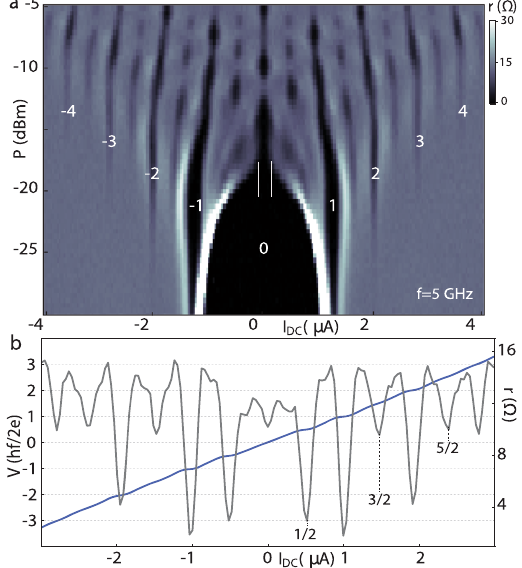
Fig. 2 AC Josephson effect. a In addition to the integer Shapiro steps, labeled in white, fractional Shapiro steps appear in between the integer ones in a plot of r ( I DC , P ). b r ( I DC ) (gray curve) and integrated voltage V ( I DC ) (blue curve) taken at an applied